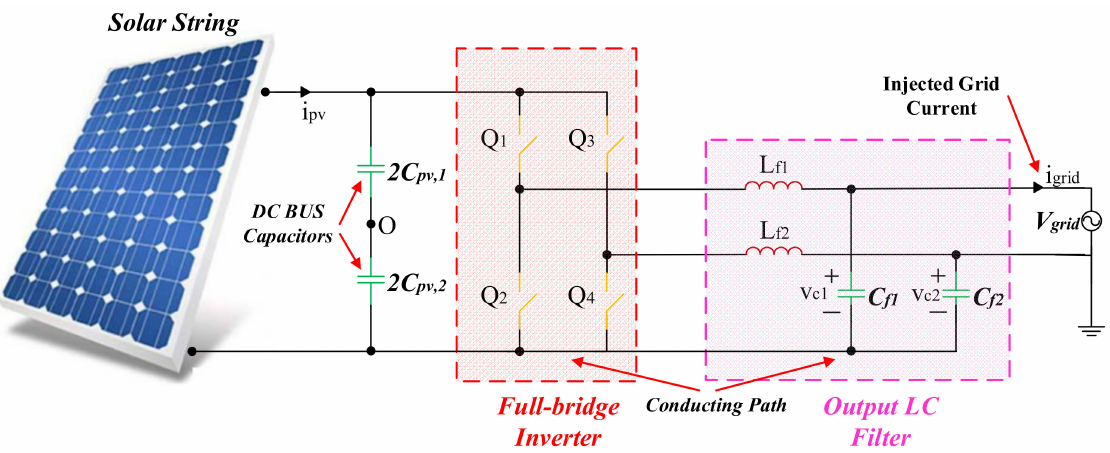
Figure 9. Common-mode path implementation for transformerless inverter for grid-connected PV